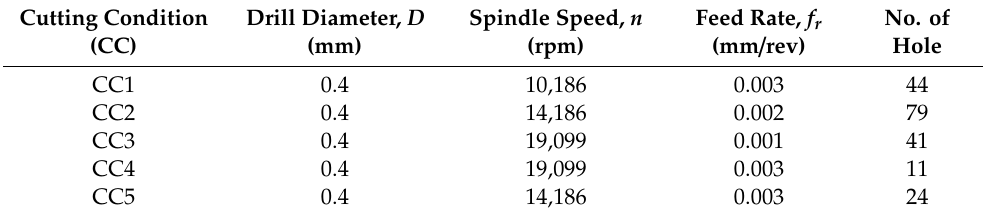
Table 1. Experimental cutting